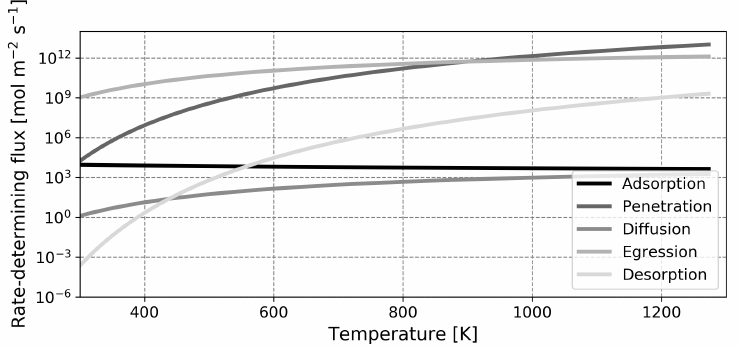
Figure 6. Representation of the hydrogen flux through a palladium membrane for different rate- determining elementary reaction steps. A membrane with a thickness of 1µm was modeled.